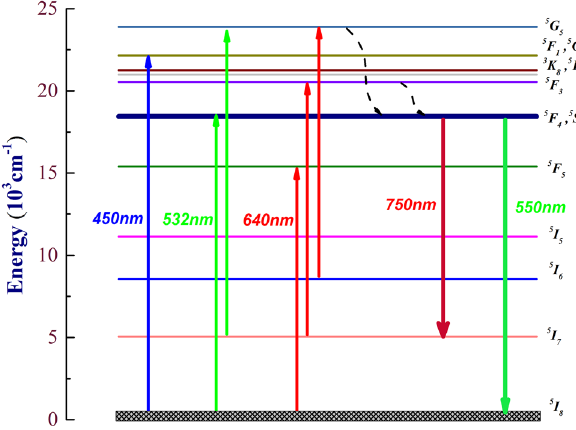
Figure 3: Partial energy-level diagram of Ho 3 + -doped ZBLAN fi ber pumped by a 532 nm solid-state